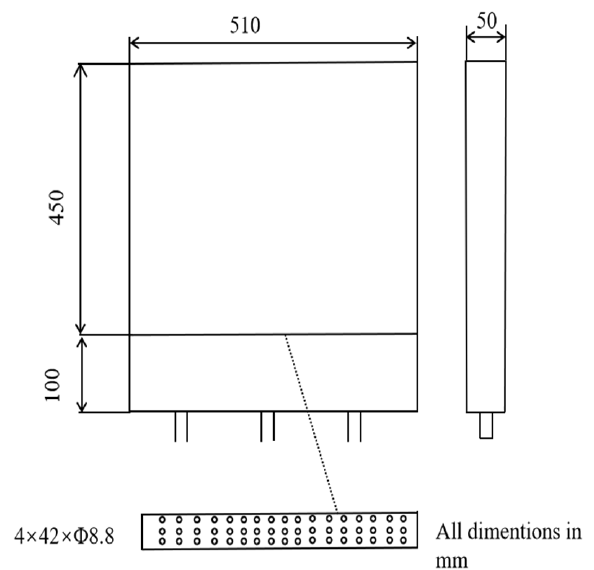
Figure 1. Structure and size of the water model.